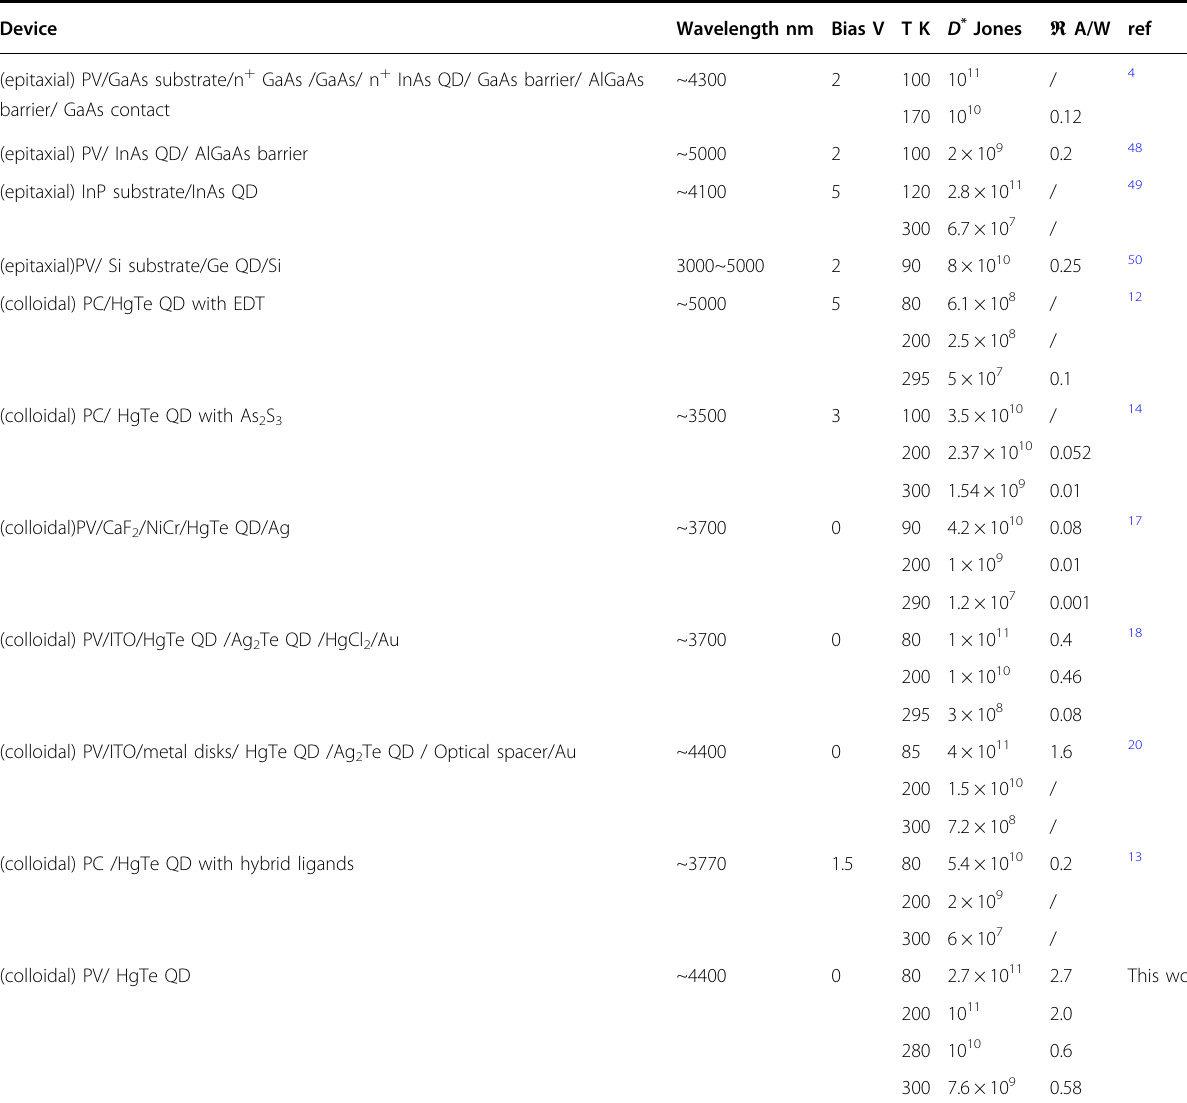
Table 1 Comparison of typical mid-IR QD photodetectors